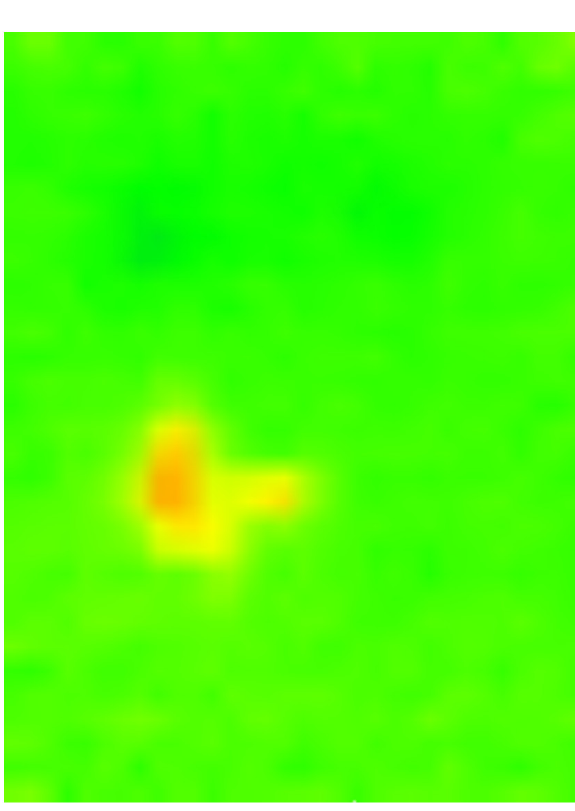
Figure 8. Thermal image.